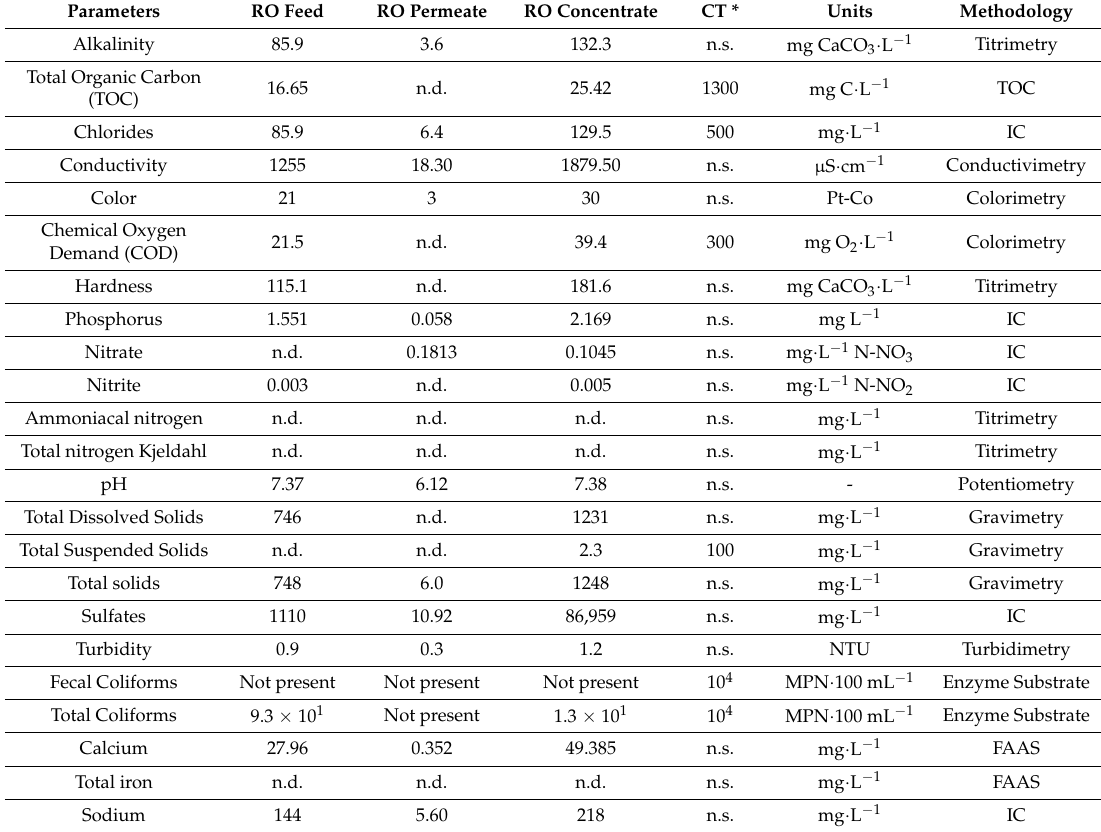
Table 1. Water quality of pre-and-post reverse osmosis (RO)